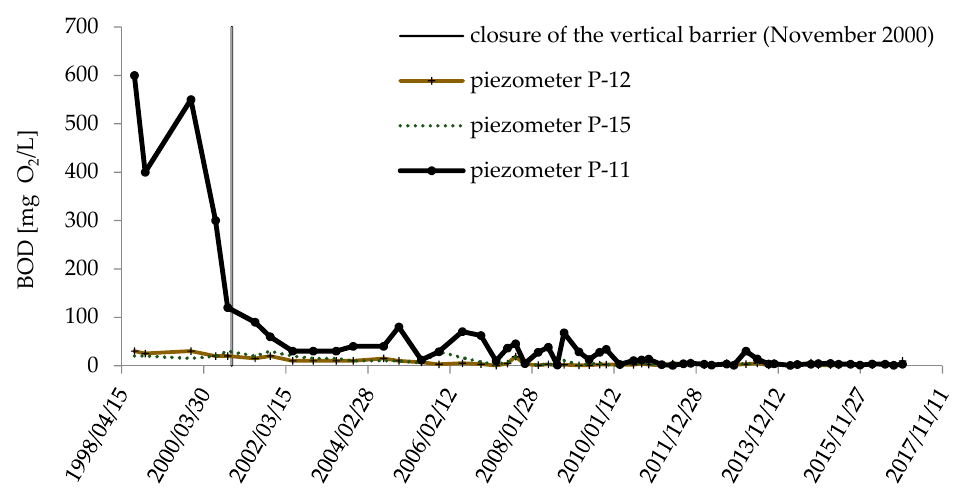
Figure 5. Temporal changes of the BOD level in piezometers located in the area of composting plant.